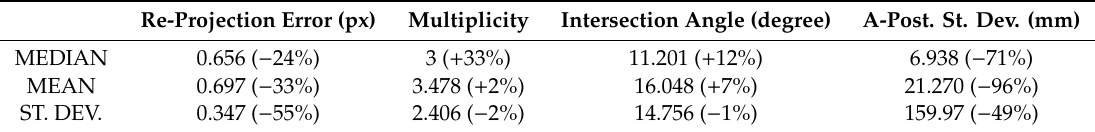
Table 16. Values of the quality parameters computed on the filtered sparse point cloud and average variation of the results.